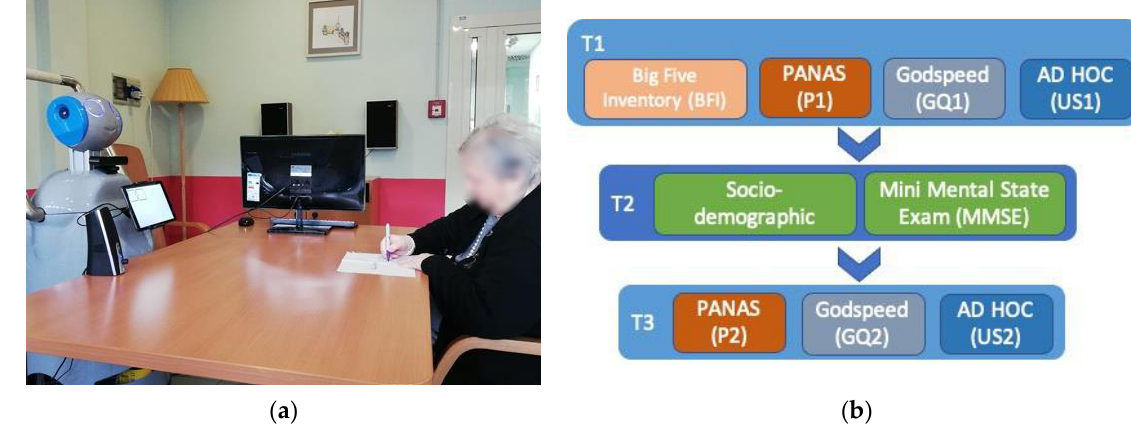
Figure 2. Experimental setup: ( a ) Elderly participant performing the drawing task of MMSE with ASTRO robot; ( b ) scheme of the experimental setup (T1 – T3 are conducted by the professional therapist; T2 administrated by ASTRO robot in WoZ).